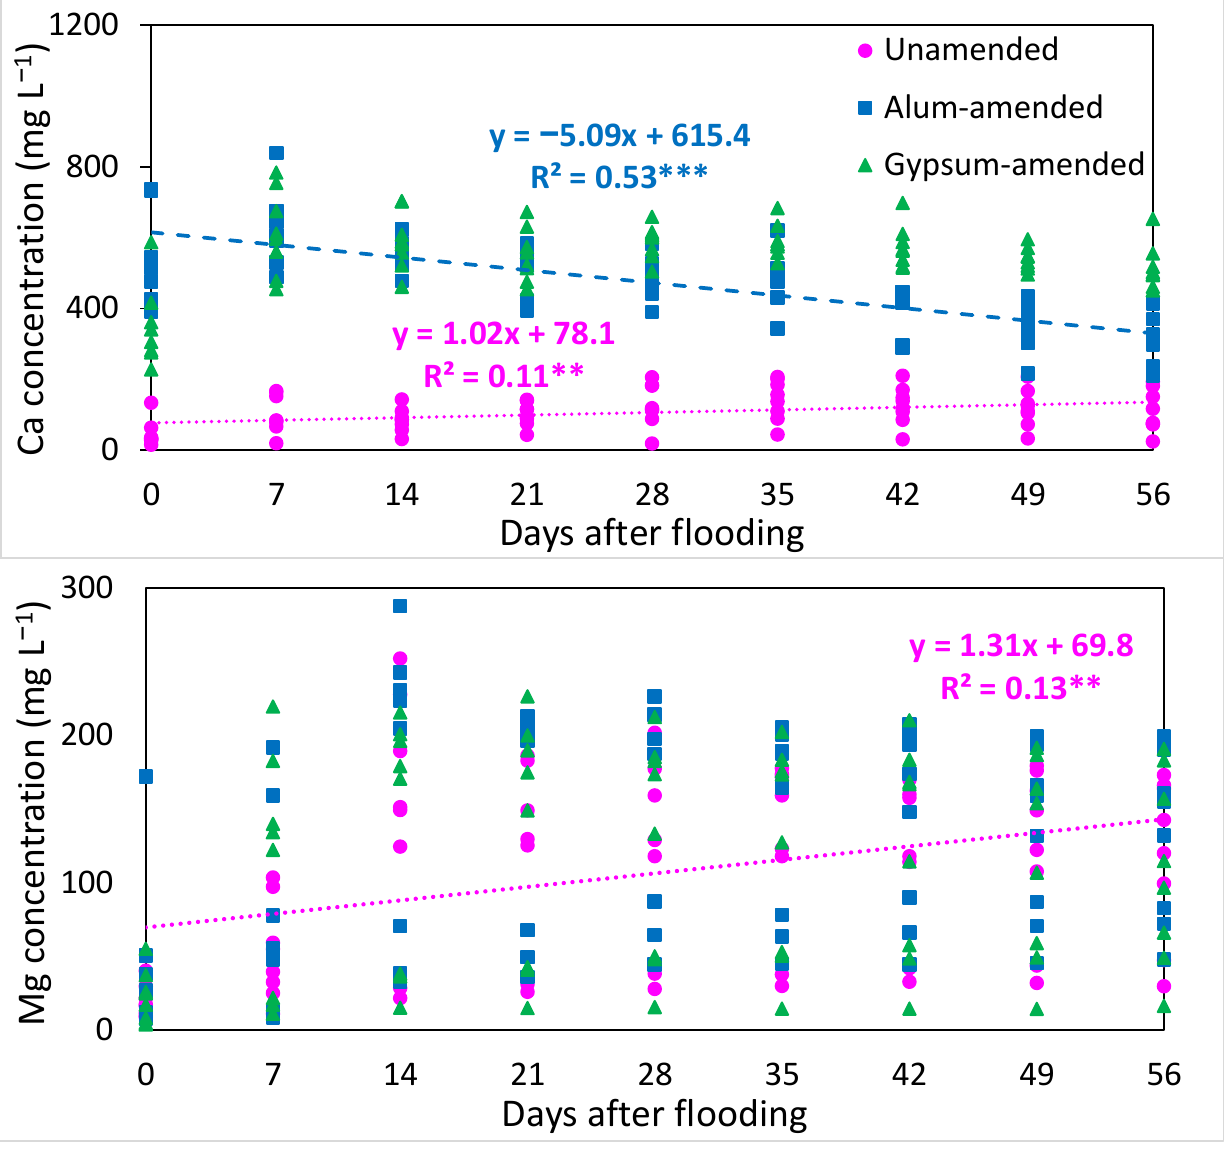
Figure 4. Relationships between days after flooding and porewater concentrations of Ca and Mg in unamended, alum-amended and gypsum-amended monoliths. Note: Linear relationships are shown only when significant at p < 0.05. Superscripts *** and ** followed by R 2 indicates significant at p < 0.001 and p < 0.01, respectively (n = 72).